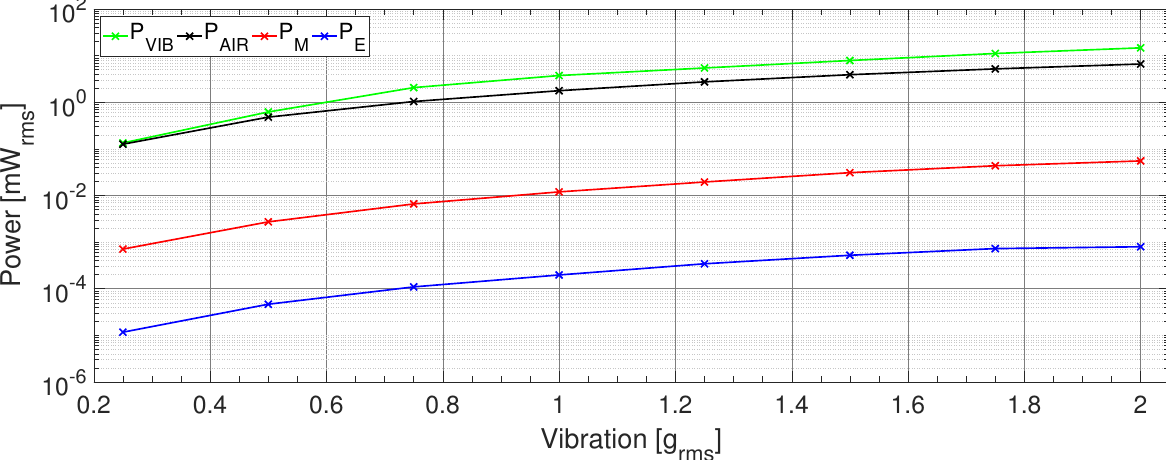
Figure 10. The PVDF PEH: Comparing the power delivered by the shaker to the PEH with the power dissipated in the air, the PEH mechanical vibration power, and the electrical power